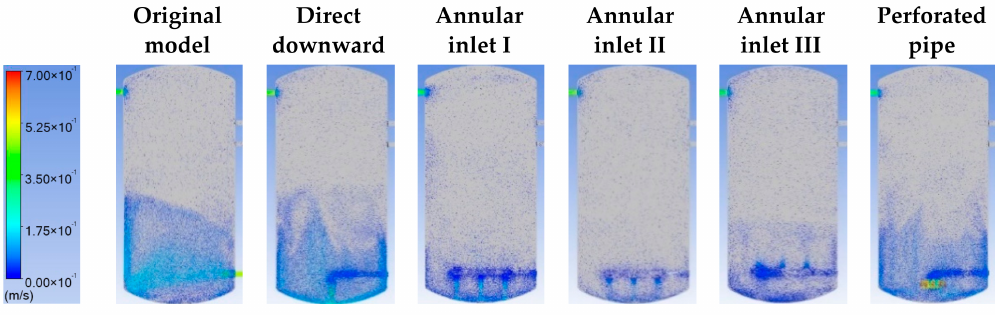
Figure 11. The velocity streams of the modified inlet pipe